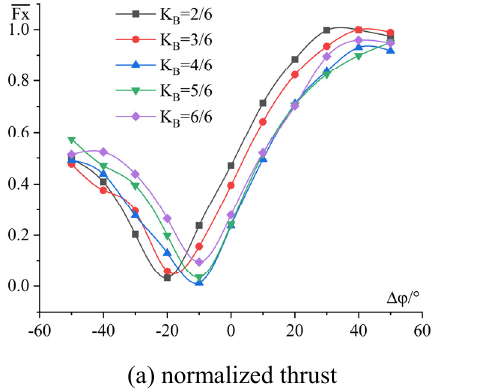
(b) normalized lift Figure 9. Effect of phase difference on leading edge.